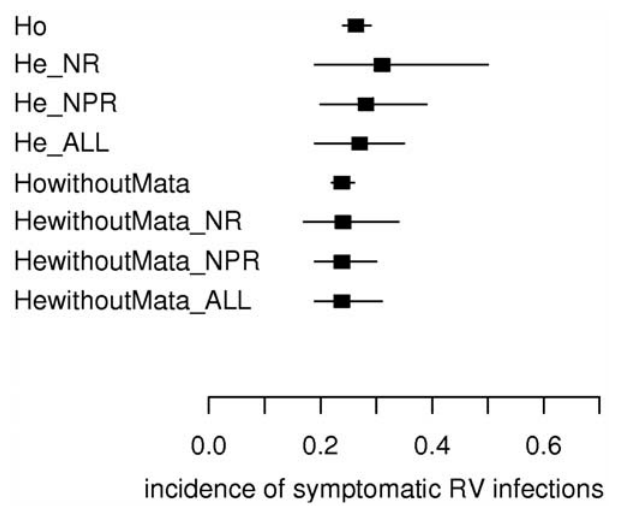
Figure 5. Impact of including/excluding studies from meta- analysis with possible high risk of bias, high risk of bias and the Mata et al paper. Impact on the pooled estimate for incidence of symptomatic RV infections for children below 2 years of age. Squares and horizontal lines represent means and 95% credible intervals of the pooled estimates. Ho=study-homogeneous model, He=study-hetero- geneous model, NR=only studies with no high risk of bias included, NPR = studies with no or possible high risk of bias included, ALL=studies with no, possible or high risk of bias included, n=number of studies included in